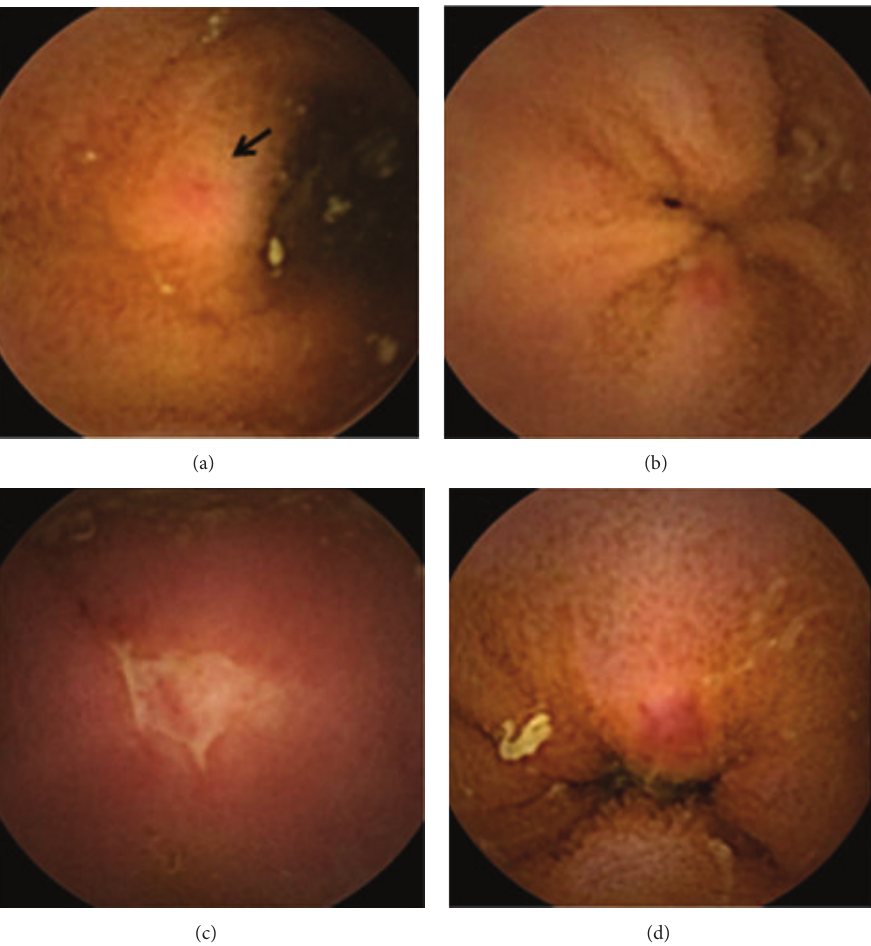
Figure 1: Capsule-endoscopic images of small bowel lesions. (a) Red spot representative of a less relevant (P1) lesion (black arrow). (b) Single erosion corresponding to a P1 lesion. (c) Ulceration representative of a highly relevant (P2) lesion. (d) Angioectasia corresponding to a P2